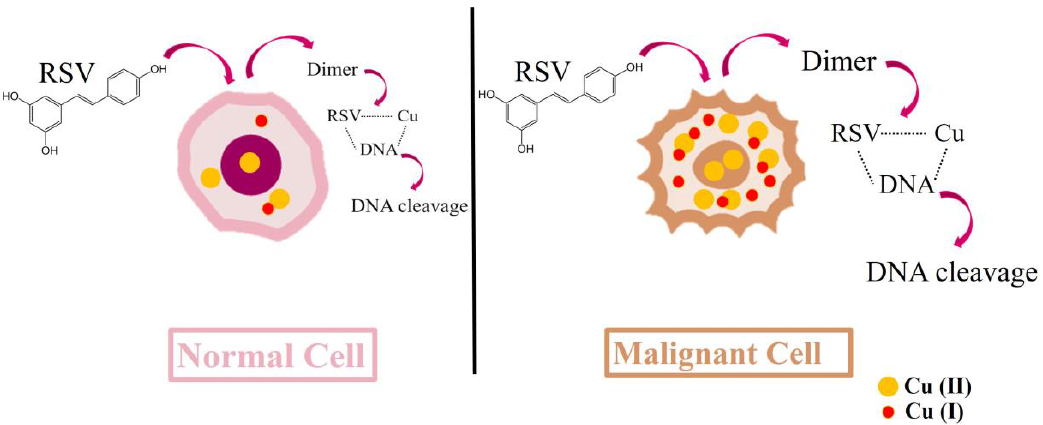
Figure 3. Resveratrol- and copper-induced cytotoxicity. The cytotoxic mechanisms of RE include the mobilization of endogenous copper ions, including chromatin-bound copper. Resveratrol undergoes oxidation in the presence of Cu(II) (which is substantially increased in the malignant cells) to a dimer. This electron transfer reduces Cu(II) to Cu(I). The dimer is capable of binding DNA to form a DNA–RE–Cu(II) ternary complex which allows the e ffi cient cleavage of DNA. Considering that RE and copper-induced DNA damage will be considerably greater in cancer cells, this mechanism offers a way for the selective killing of cancer cells by using high concentrations of RE.